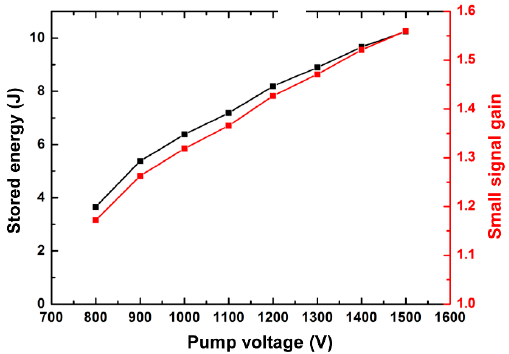
Figure 3. Stored energy and small signal gain versus pump